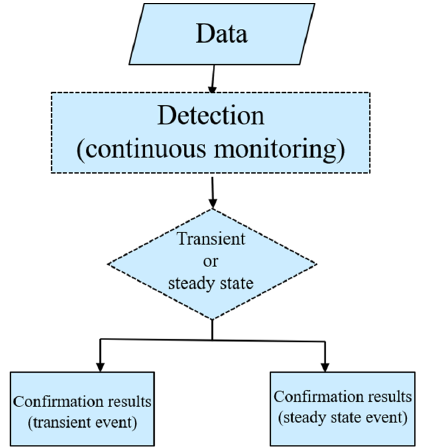
Figure 13. Flow chart of automatic encoder system.